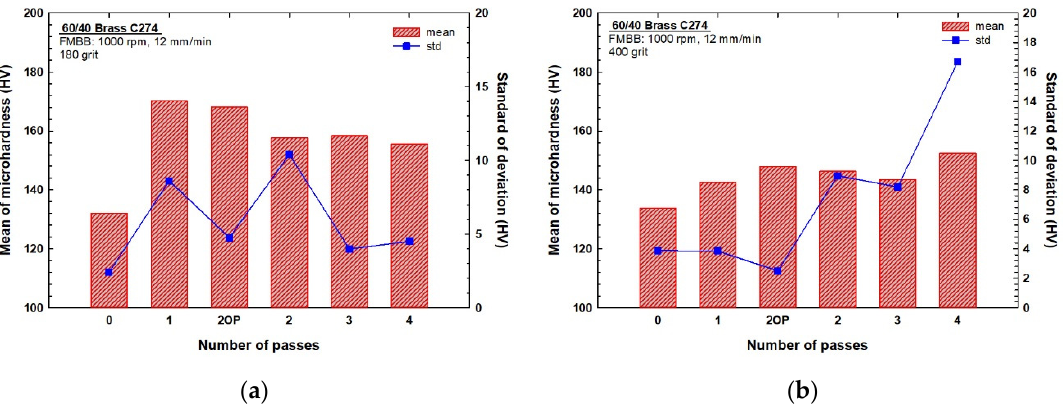
Figure 3. Microhardness values (means and standard deviations) for different burnishing passes ground with ( a ) 180 grit and ( b ) 400 grit.